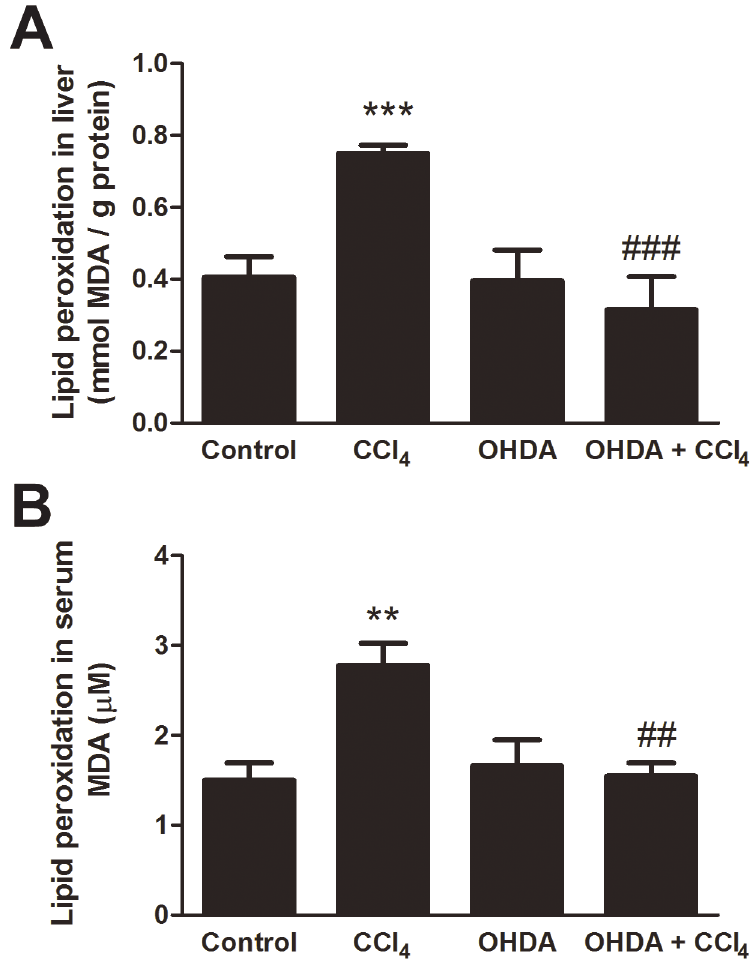
Fig 6. Prevention by sympathetic denervation of CCl 4 -induced lipid peroxidation. Mice were treated or not treated for 24 h with CCl 4 , with or without pretreatment with 6-OHDA. Lipid peroxidation was assessed by malondialdehyde (MDA) measurement in liver homogenates (A) and serum (B). Results are expressed as mmol/g protein in liver homogenates and μ M in serum. Data are mean ± SD for 6 mice per group. In all figures, significant differences are noted as ** p < 0.01 vs. control, ## p < 0.01 vs. CCl 4 , *** p < 0.001 vs. control, and ### p < 0.001 vs. CCl 4